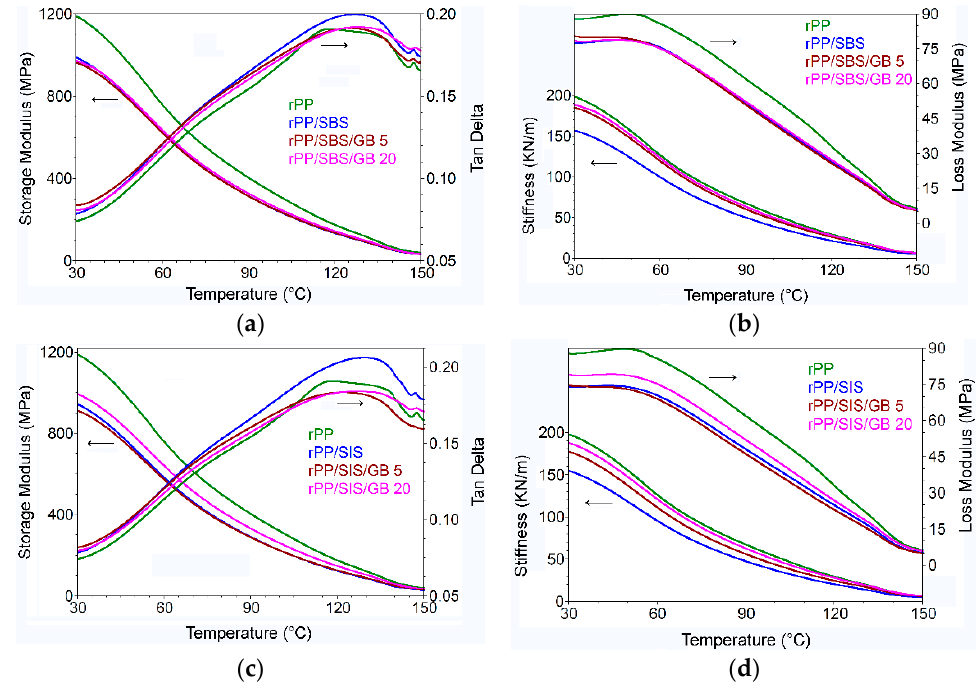
Figure 8. Dynamic mechanical analysis (DMA) analysis. Storage modulus and tan δ for: ( a ) post- consumer rPP/SBS/GB and ( c ) post-consumer rPP/SIS/GB; Loss Modulus and stiffness for: ( b ) post- consumer rPP/SBS/GB and ( d ) post-consumer rPP/SIS/GB.